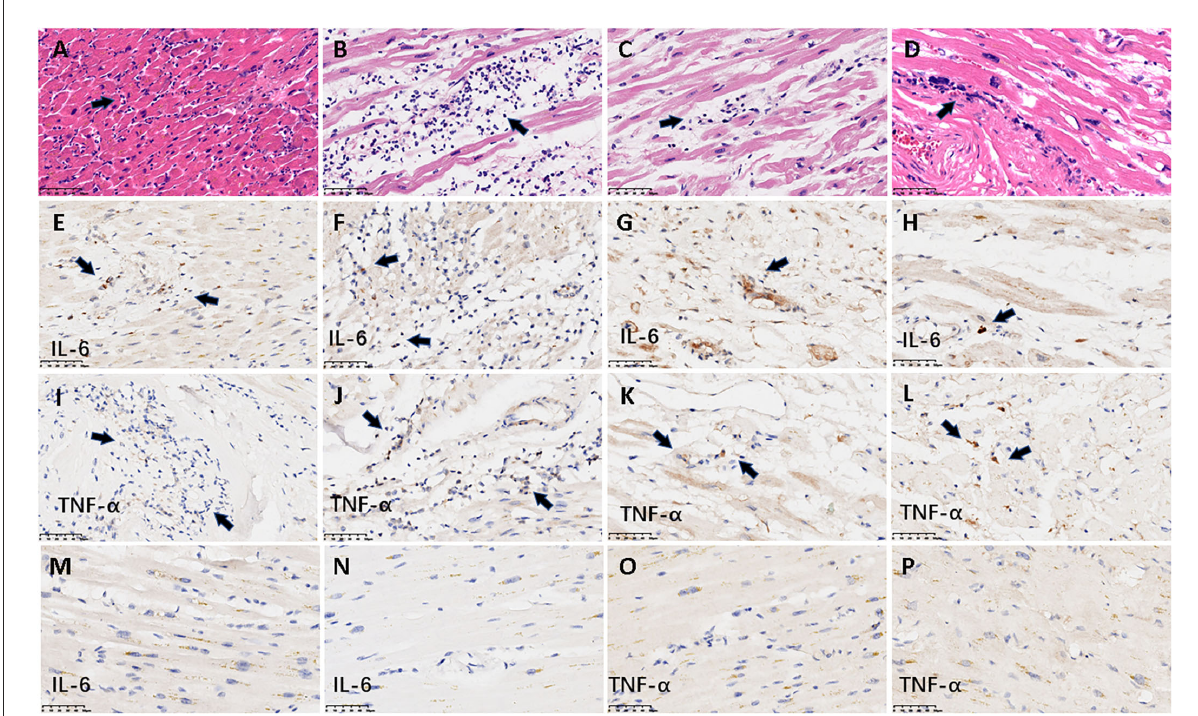
FIGURE1 Representative histological and IHC findings from hearts. The figure shows the histological and IHC findings from heart tissues. (A–D) demonstrate active myocarditis in the four cases. (A,B) The histology in the myocardium demonstrated diffuse neutrophilic infiltrates with myocyte injury in a 62-year-old man and a 56-year-old woman, respectively; (C,D) multiple small discrete foci of mixed inflammatory cells with visible neutrophils associated with single-cell necrosis of cardiomyocytes in a 63-year-old woman and a 76-year-old man, respectively. The arrows denote the infiltrated neutrophils. (E–L) denote the positive IHC staining of IL-6 and TNF- α from the four cases with active myocarditis. (E–H) IL-6; (I–L) TNF- α . The longitudinal images in the first three rows were derived from the same case (A, E, I from a 62-year-old man; B, F, J from a 56-year-old woman; C, G, K from a 63-year-old woman; D, H, L from a 76-year-old man). Arrows denote the positive signal of IHC staining. (M–P) Represent the negative expression of IL-6 and TNF- α from two cases without neutrophil infiltration. (M,O) IHC staining from an